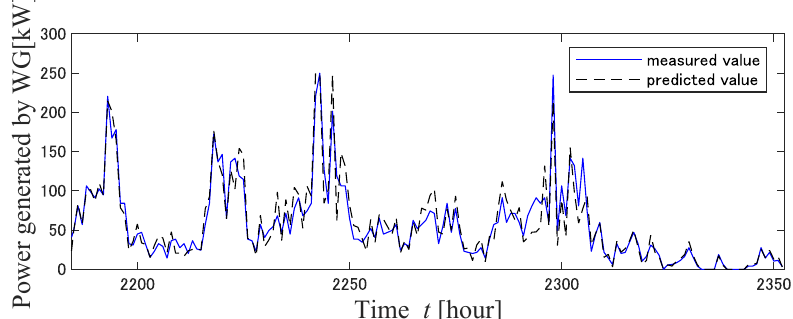
Figure 8. Power generated by WG (summer).